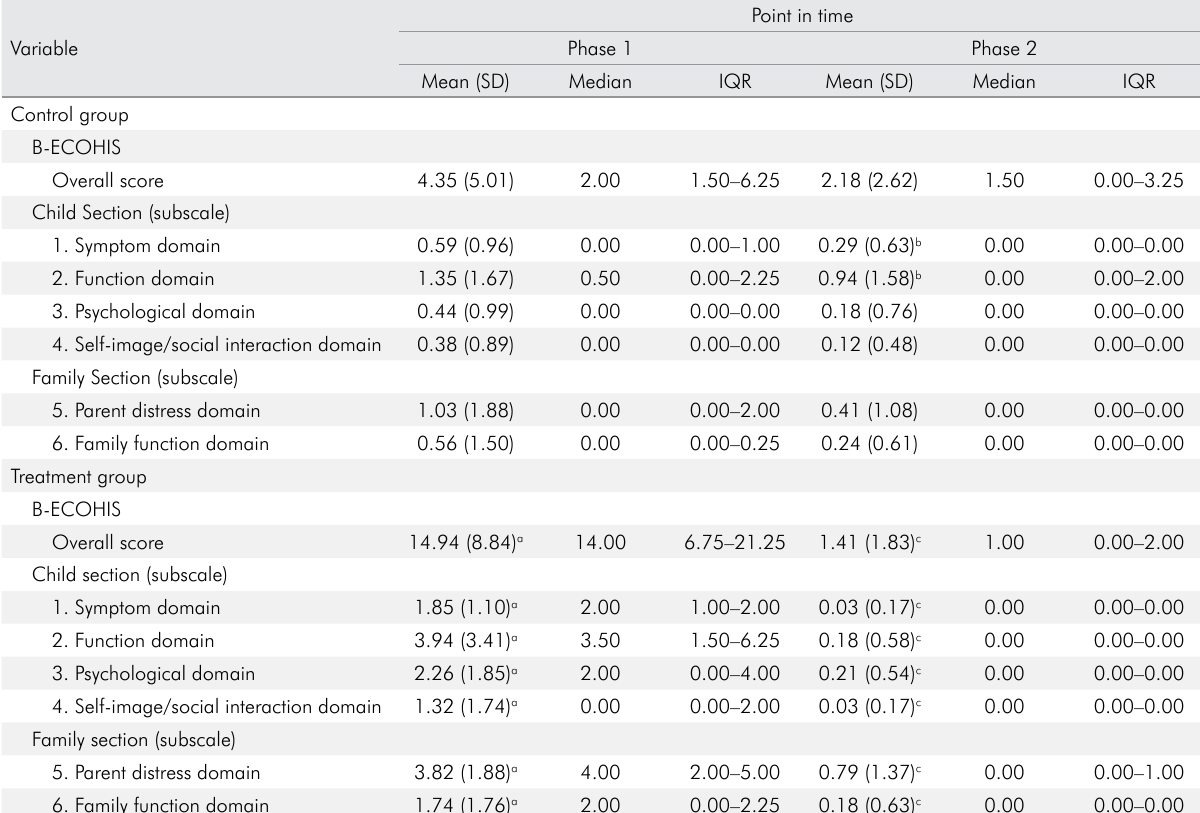
Table 3. Measures of central tendency and variability in B-ECOHIS and subscale scores according to group and point in time [control and treatment groups in Phases 1 and